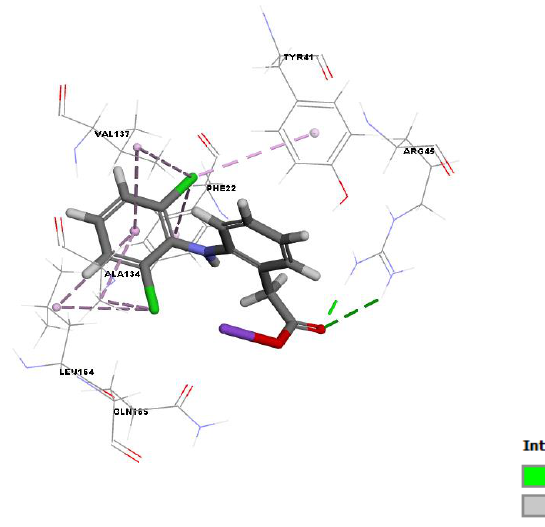
Table 2. Molecular modeling results.